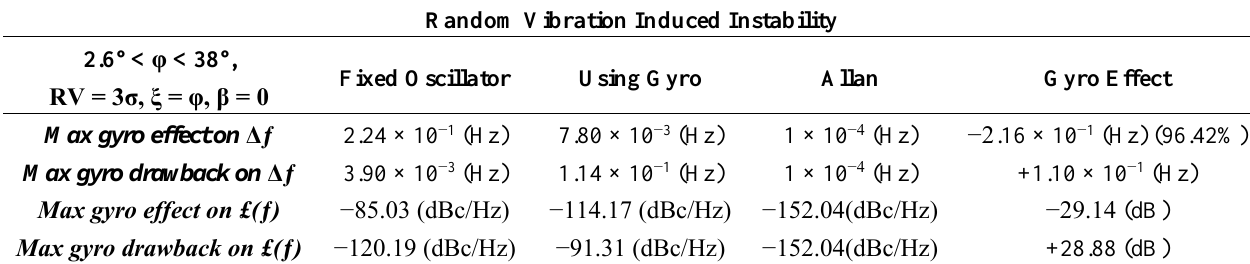
Table 8. Maximum effects and drawbacks of gyroscopic mounting on random vibration.